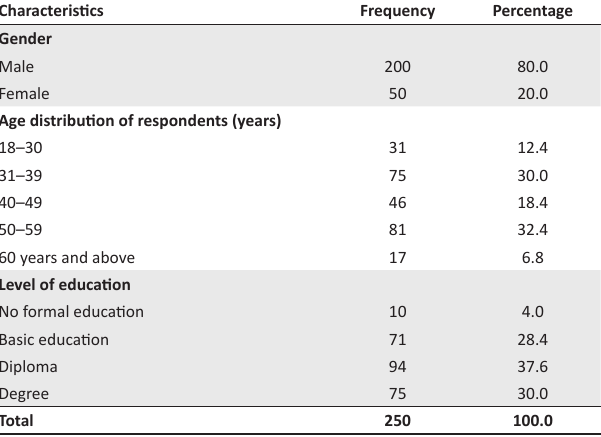
TABLE 3: Sample demographic characteristics.